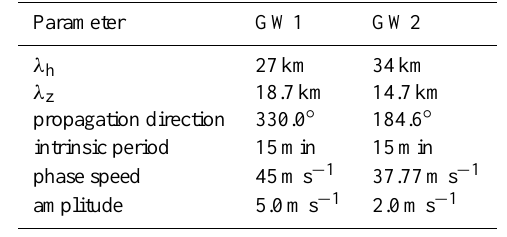
Table 2. Gravity wave parameters used for the simulation. Here λ h and λ z denote the horizontal and vertical wavelength of the GW, respectively.